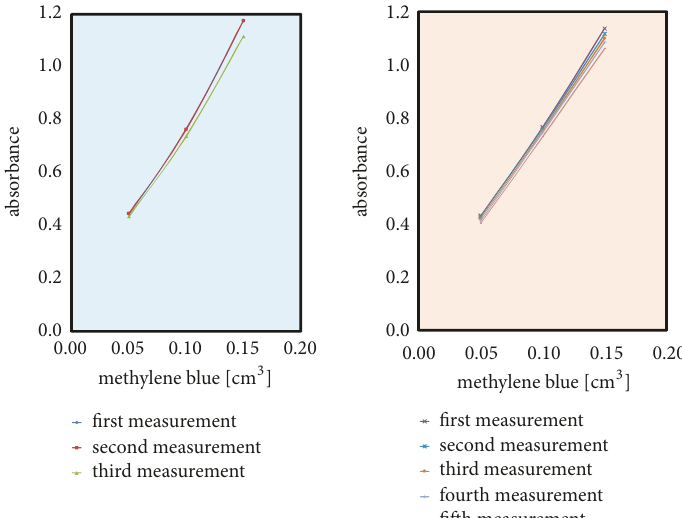
Figure 4: Absorbance at 660 nm for selected concentration in function of amount of dye.